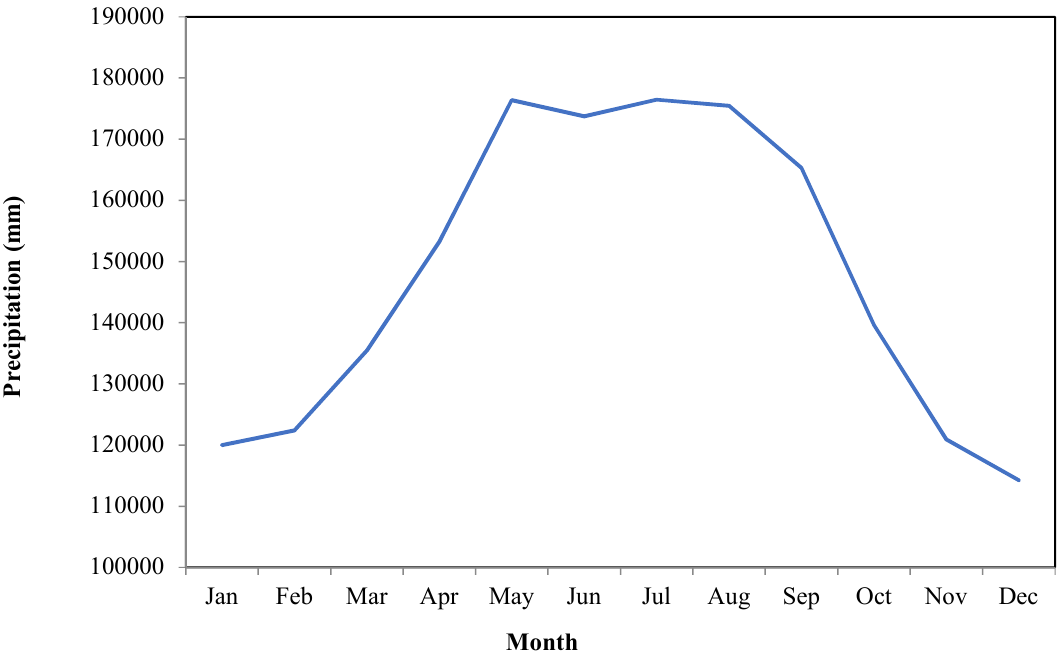
Figure 3. Average power generation in the Dez hydropower plant. Table 1. Presenting the datasets and the statistical characteristics.